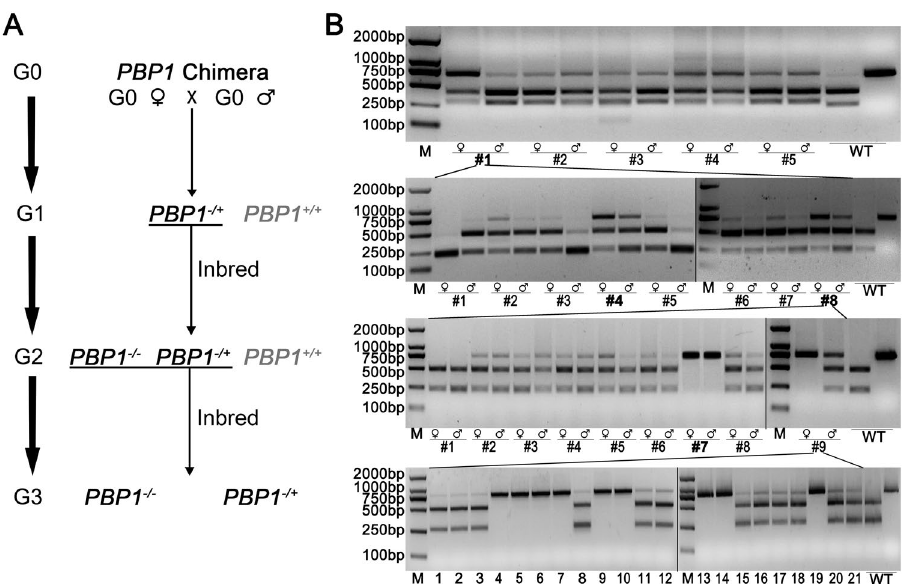
Figure 2. Screening of homozygous mutant H. armigera targeting at PBP1 . (A ) Schematic of screening strategies to select homozygous mutants. The G2 PBP1 − / − homozygotes were obtained by G1 PBP1 − / +